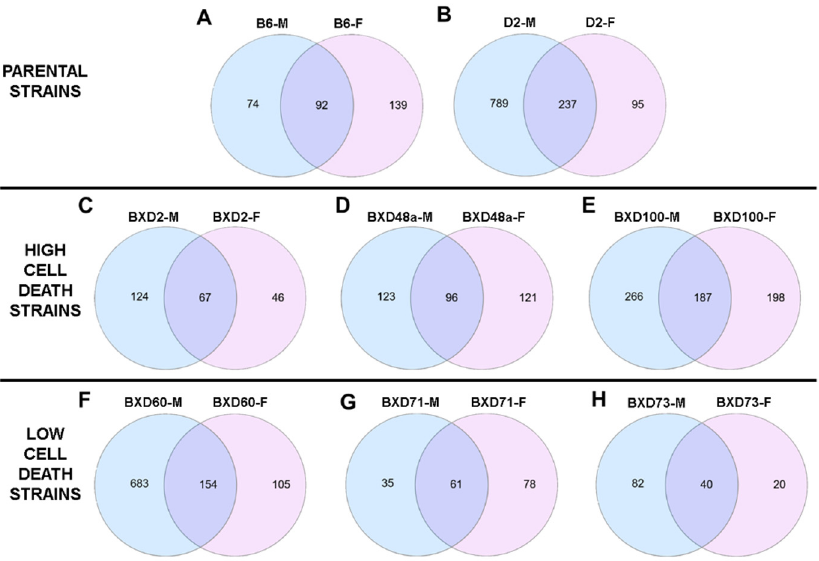
Figure 2. Sex-specific ethanol-induced gene expression for each strain. Differential effects of sex in the parental strains: ( A ) B6 and ( B ) D2 (top); the high cell death strains (middle): ( C ) BXD2, ( D ) BXD48a, and ( E ) BXD100; and low cell death strains (bottom): ( F ) BXD60, ( G ) BXD71, and ( H ) BXD73. For each strain, the number of significant ( adjp < 0.05) ethanol-induced gene expression changes in males (blue circles, left) and females (pink circles, right). The purple overlap between the two circles (middle) represent number of significant ( adjp < 0.05) ethanol-induced gene expression changes that were present in both males and females in each strain.